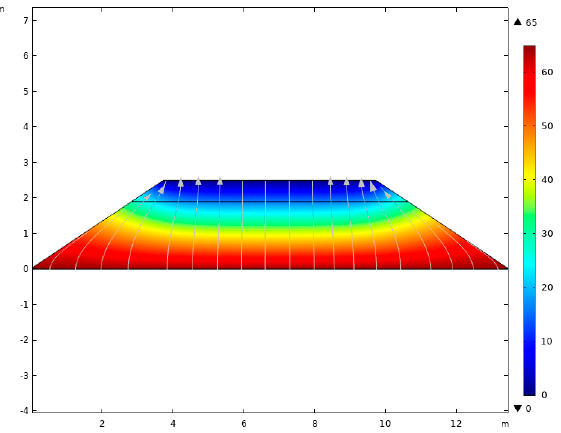
Figure 12. Distribution diagram of pore water pressure in saturated zone of railway subgrade with time is 5000 min (unit: kPa).